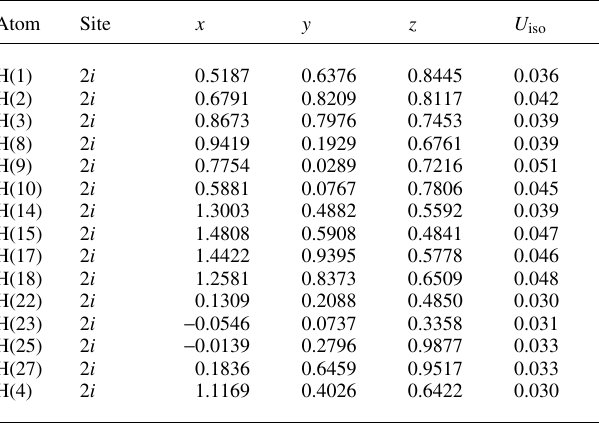
Table 2. Atomic coordinates and displacement parameters (in Å 2 )